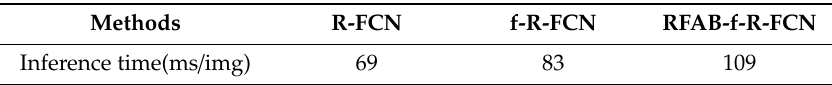
Table 6. Comparison of inference time between different improvement schemes.